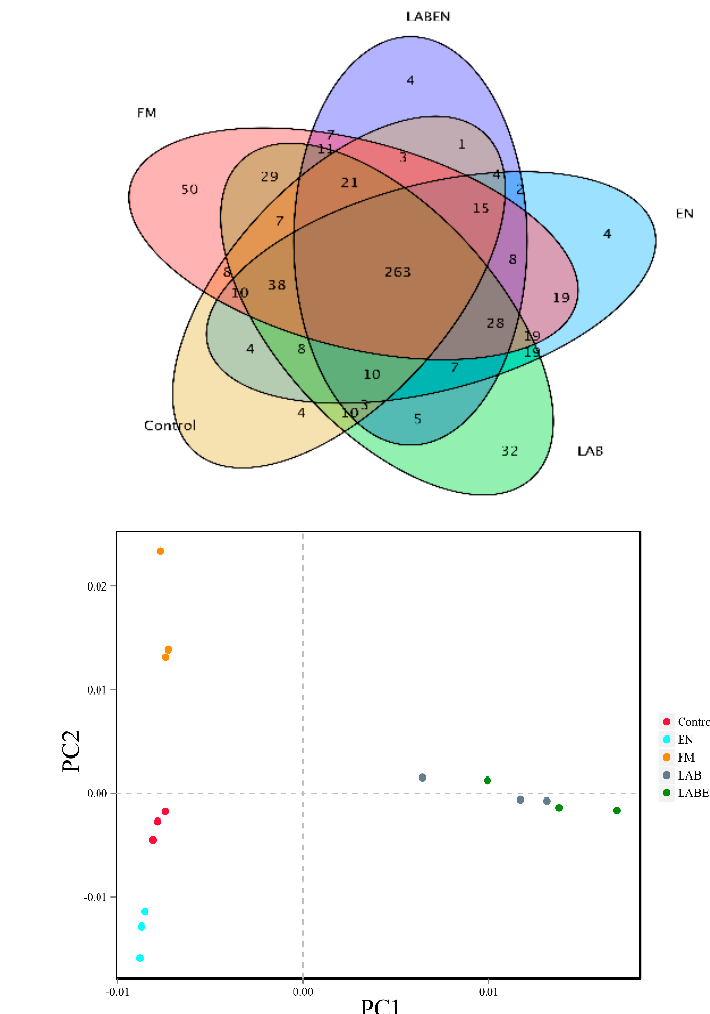
Figure 1. Venn analysis of operational taxonomic units ( a ) and the principal component analysis ( b ) of bacterial communities after 30 days of ensiling. FM, fresh material. Treatments, control, no additive; LAB, lactic acid bacteria; EN, 1 g fibrolytic enzyme per 1 kg FM; LABEN: combine lactic acid bacteria with 1 g fibrolytic enzyme per 1 kg FM.